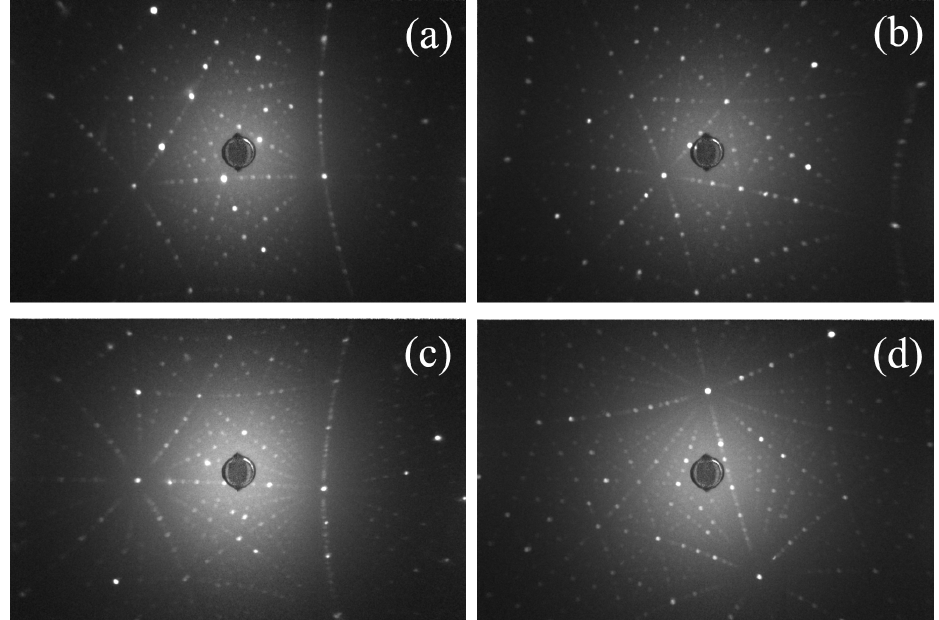
Figure 3. Laure graph of ( a ) as-grown Eu:GAP crystal; ( b ) annealed Eu:GAP crystal; ( c ) Eu:GLAP single crystals; ( d ) annealed Eu:GLAP crystal.